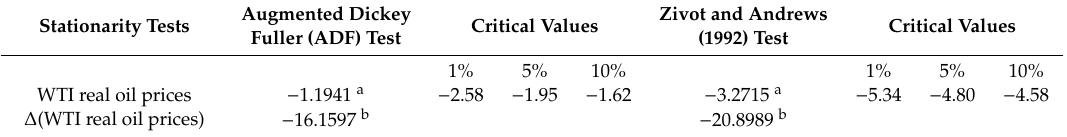
Table 2. Unit root tests for the West Texas Intermediate (WTI) real price between 1 / 1 / 1947 and 1 / 9 / 2018.